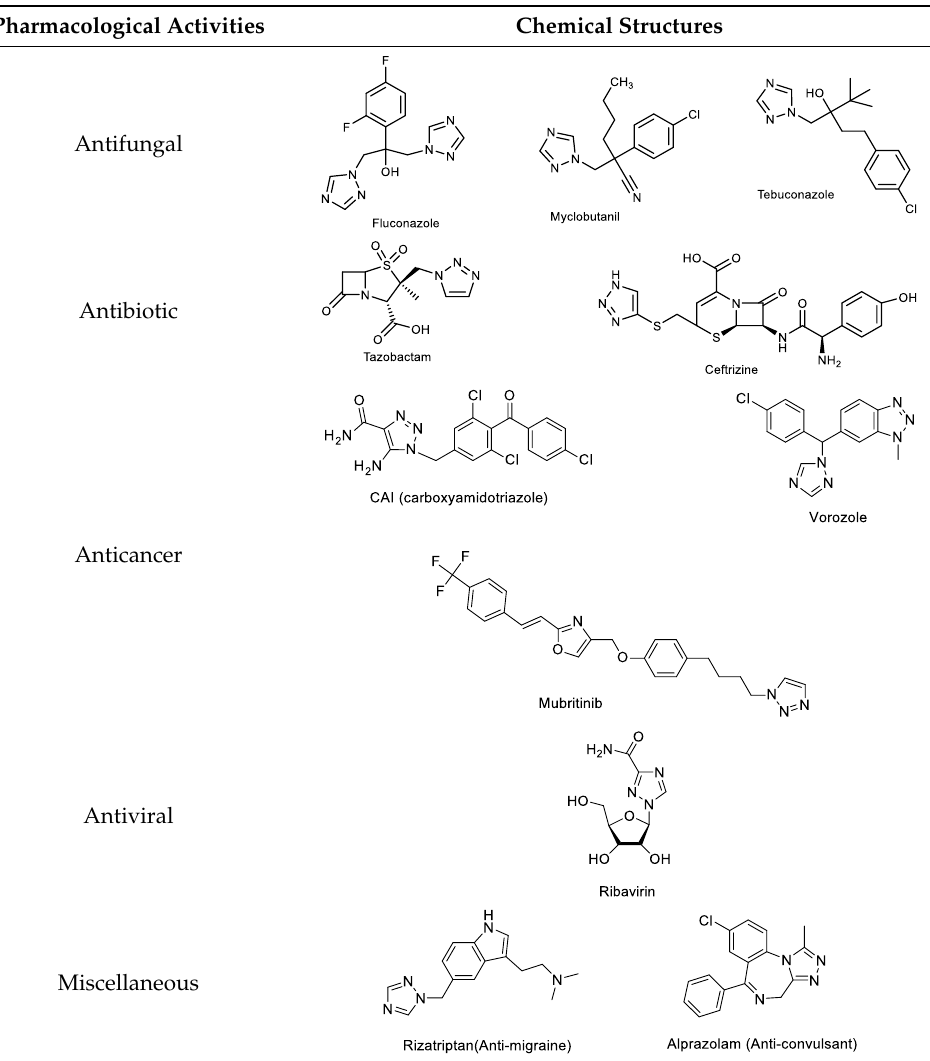
Table 1. Therapeutic actions and chemical structures of triazole-based molecules.